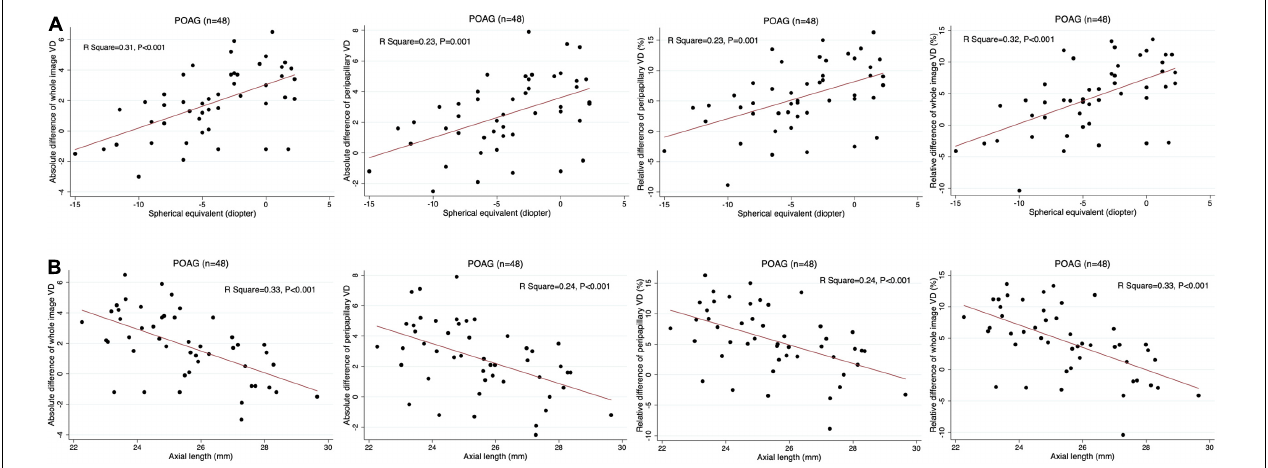
FIGURE 2 | Scatter plots presenting the linear correlations between vessel density (VD) differences and spherical equivalent and axial length in POAG eyes. Absolute and relative difference of the whole-image and peripapillary VD are significantly correlated with spherical equivalent (A) and axial length (B) in POAG eyes,